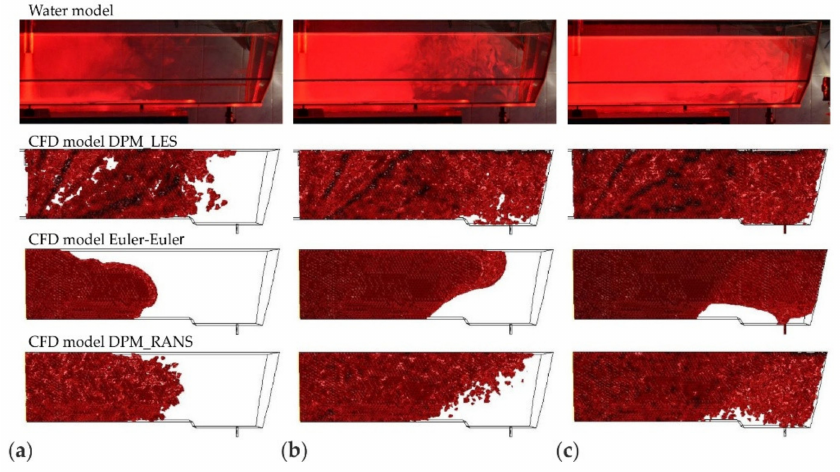
Figure 8. The location of the microparticles (fraction 20 µ m) in the tundish model for a duration of, respectively: ( a ) 25, ( b ) 60, ( c ) 120 s.